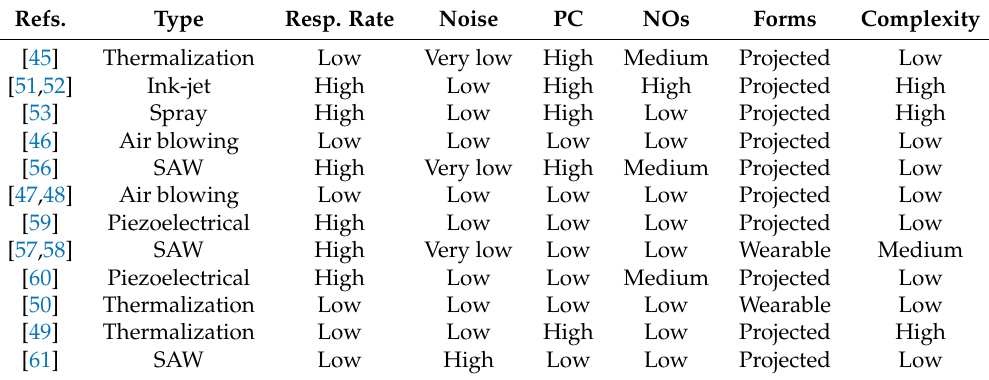
Table 2. Performance comparison of olfactory displays. Resp., response; PC, power consumption; NOs, number of odors; SAW, surface acoustic wave.